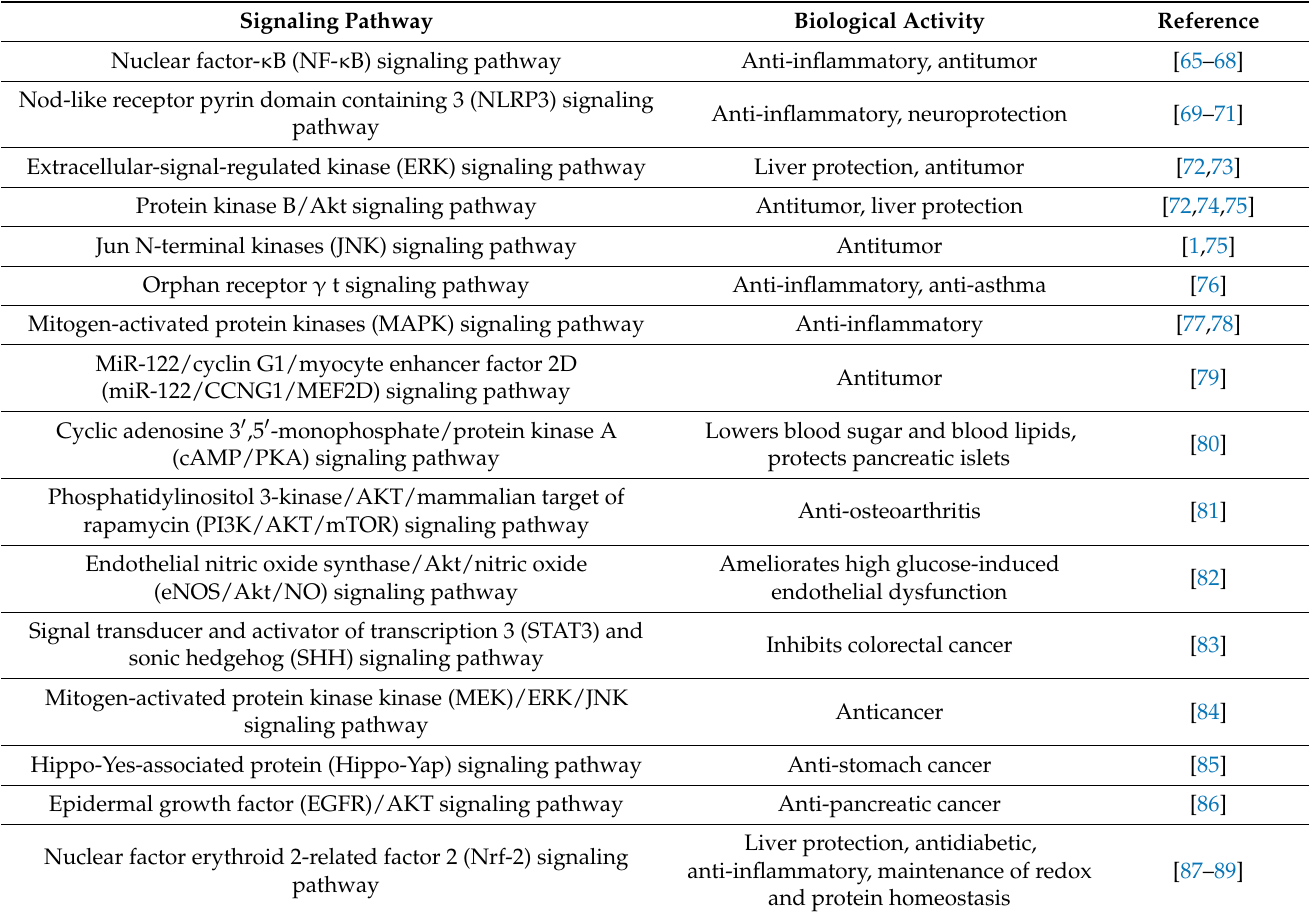
Table 2. Pharmacological actions and signaling pathways of